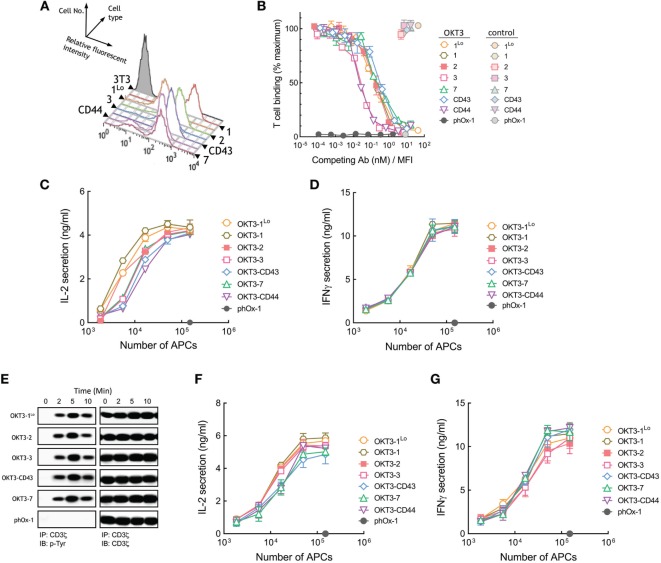
Membrane-tethered OKT3 scFv activates Jurkat T cells in a length-independent manner. (A) Surface expression of membrane-tethered OKT3 scFv on 3T3 cells was measured by FACS. OKT3-1Lo cells express low levels of OKT3 scFv via the BGP tether (one Ig-like domain). (B) Calcein-AM-labeled Jurkat T cells were incubated with monolayers of 3T3 cells expressing membrane-tethered OKT3 scFv in the presence of serial dilutions of OKT3 IgG (dark symbols) or 10 µg/ml negative control IgG (light symbols). phOx-1 cells express a negative control scFv fused to the BGP tether. Unbound T cells were washed away and cellular fluorescence of the remaining bound cells was measured (n = 3). The y-axis shows the mean fluorescence of bound T cells, whereas the x-axis represents the concentration of soluble OKT3 IgG added normalized for the level of each membrane-tethered OKT scFv, as determined by mean immunofluorescence intensity of the 3T3 antigen-presenting cells (APCs) stained with anti-HA antibody. Bars, SD. (C) 5 × 104 Jurkat T cells were incubated for 24 h with the indicated numbers of OKT3 APCs (OKT3-1, OKT3-1Lo, OKT3-2, OKT3-3, OKT3-7, OKT3-CD44, OKT3-C43) or control phOx-1 APCs before the concentration of IL2 (C) or IFN-γ (D) in the culture medium was determined (n = 3). Bars, SD. (E) 107 Jurkat T cells were incubated with 106 OKT3 APCs (OKT3-1Lo, OKT3-2, OKT3-3, OKT3-C43, OKT3-7) or control phOx-1 APCs for the indicated time before cells were lysed and CD3ζ was immunoprecipitated. Total CD3ζ (right panel) or phosphorylated CD3ζ (left panel) levels were determined by immunoblotting with anti-CD3ζ or anti-phosphotyrosine antibodies, respectively. 5 × 104 naïve human T cells were incubated with the indicated number of OKT3 APCs for 24 h before the concentration of IL-2 (F) or IFN-γ (G) in the culture medium was determined (n = 3). Bars, SD.